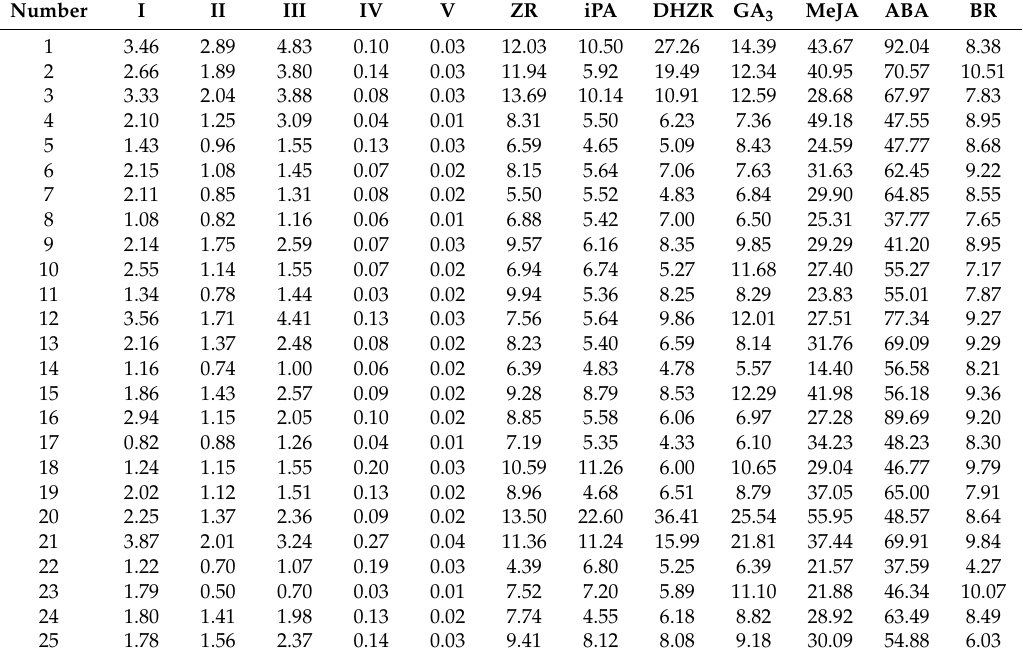
Table 1. Variation in contents of five main active components and seven phytohormone levels in different plants of G. uralensis . ZR, zeatin riboside; iPA, indolepropionic acid; DHZR,